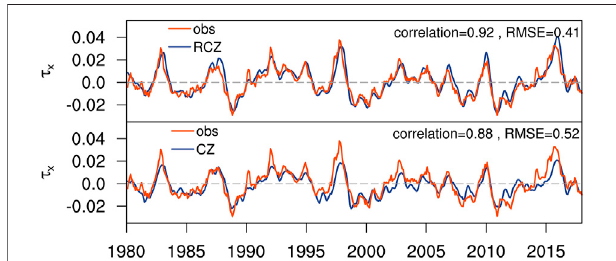
FIGURE5| Upperpanel:Timeseriesoftheobserved(redline)andRCZ- simulated (blue line) equatorial (5 ° S – 5 ° N average) zonal wind stress anomalies averagedbetween150 ° Eand150 ° W.Thecorrelationbetweentheredlineand the blue line, along with the standardized root mean square error of the simulated equatorial zonal wind stress anomalies, is indicated in the upper- right corner. Setting of the model simulation is the same as that in Figure 4 . The zonal wind stress anomalies have been smoothed through the 3-month running average. Lower panel: Same as the upper panel, except that the blue line denotes the CZ model-simulated equatorial zonal wind stress anomalies.